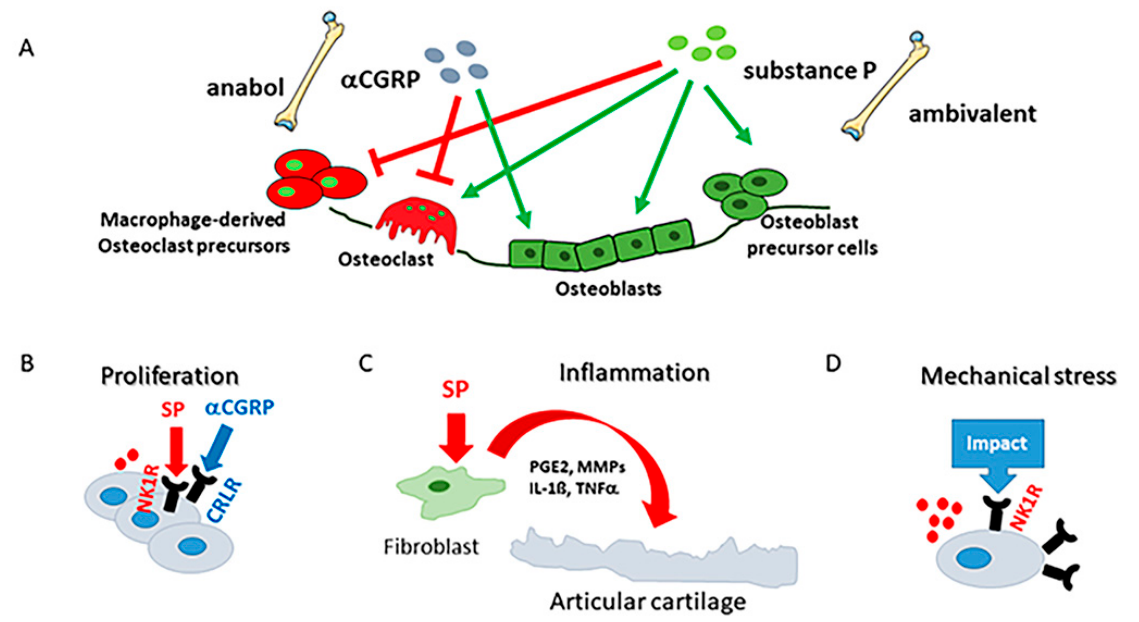
Figure 3. Sensory neuropeptides modulate bone and cartilage metabolism. ( A ) Effects of α CGRP (alpha-calcitonin gene- related peptide) and SP (substance P) on bone cell metabolism. Whereas α CGRP exerts mainly anabolic effects, SP signaling has an ambivalent nature. ( B ) Both substance P and α CGRP decrease proliferation of OA chondrocytes. ( C ) Stimulation of synovial fibroblasts with SP induces release of inflammatory mediators promoting cartilage degradation. ( D ) Application of mechanical load increases expression of NK1R (neurokinin 1 receptor) and endogenous synthesis of Substance P. CRLR, calcitonin receptor-like receptor; PGE2, prostaglandin E 2 . Adapted from reference [10].